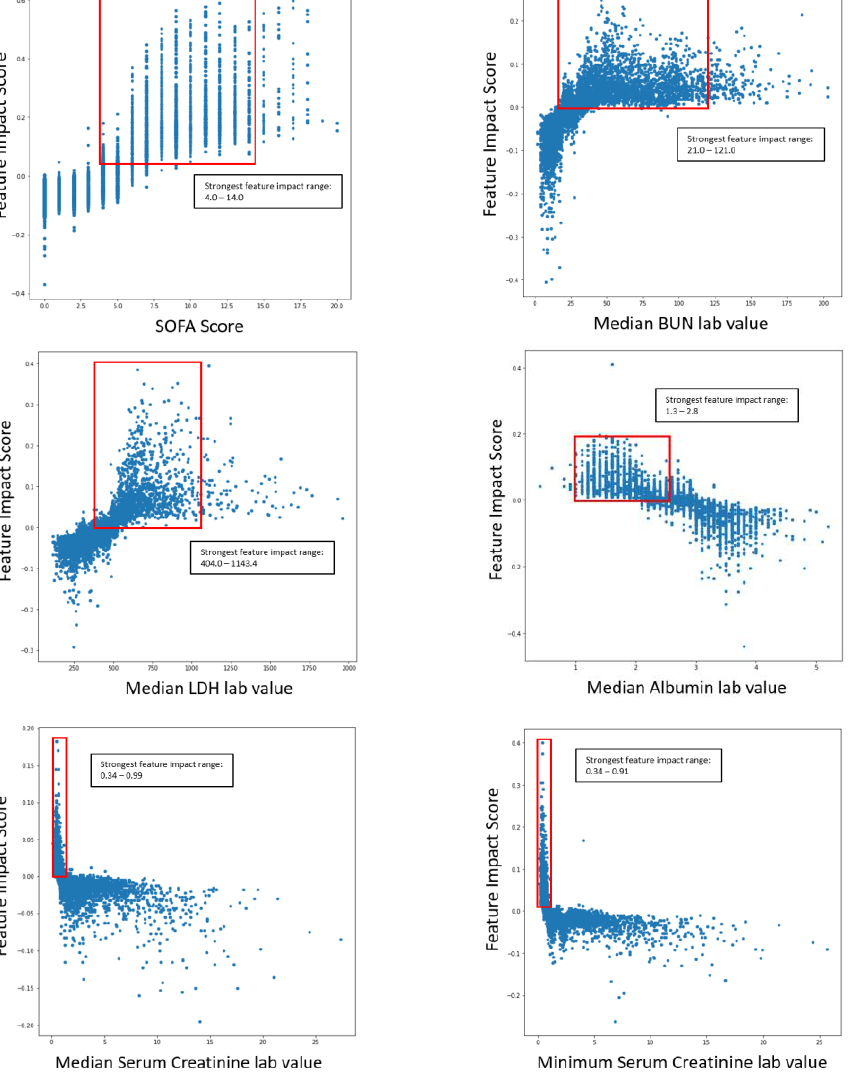
Figure 8. Range of impactful and validated biomarker values for COVID-19 severity prediction. The ranges of values were calculated by measuring the 5th and 95th quantile of biomarker values when the severity was high. The same logic was applied to survival models. The following graphs in Figure 9 outline the specific range of values within scatter plots for impactful features concerning COVID-19